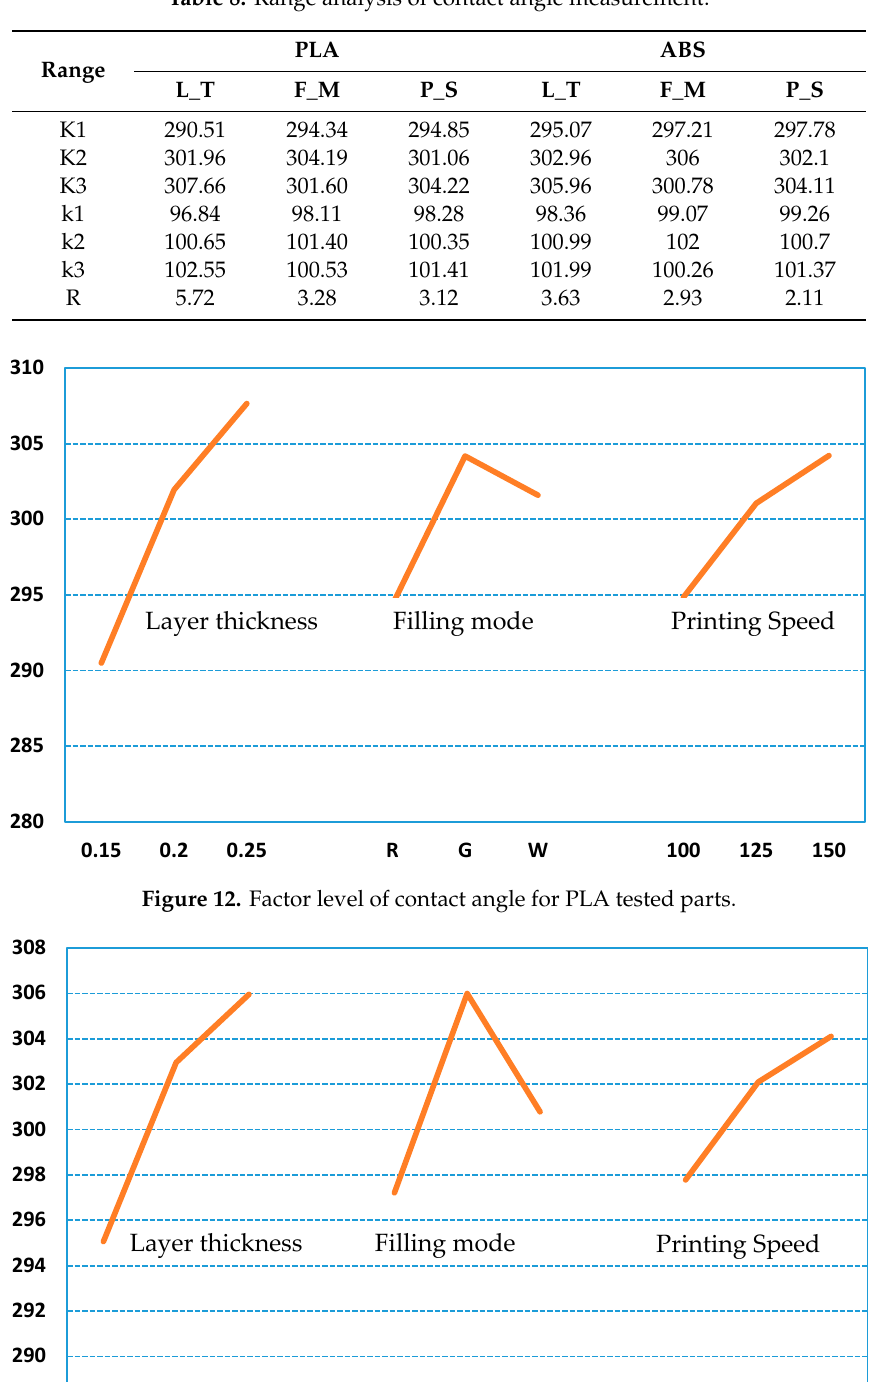
Table 8. Range analysis of contact angle measurement.